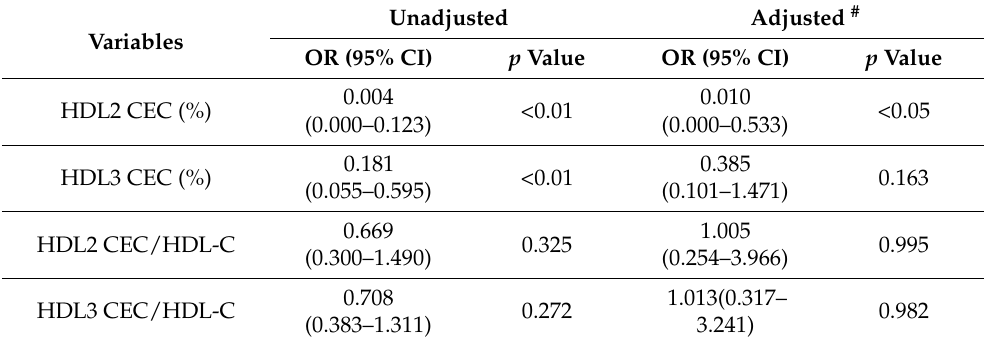
Table 5. Binary logistic regression for CEC in relation to HOFH (Reference: